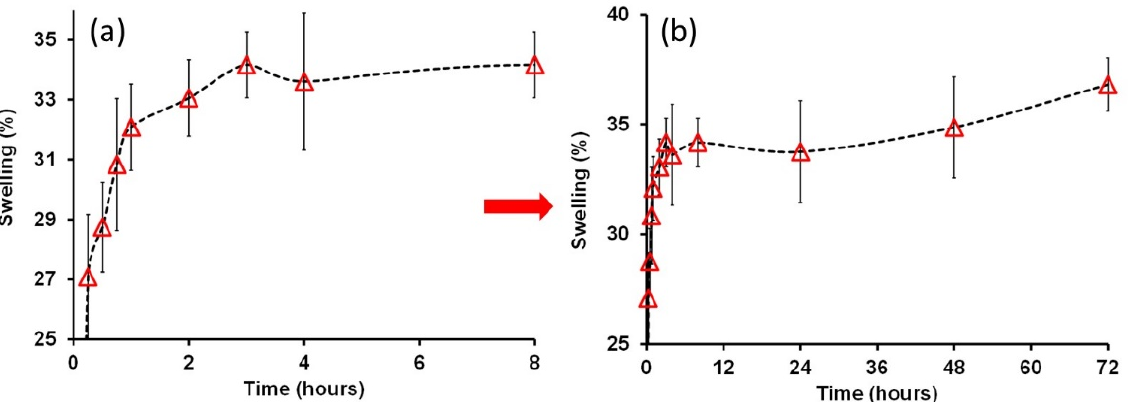
Figure 7. Percent swelling measurements for the PU/PVP_50/50 film monitored for up to three days. ( a ) The initial 8 hours is displayed in detail and ( b ) the full 3 ‐ day plot is presented.